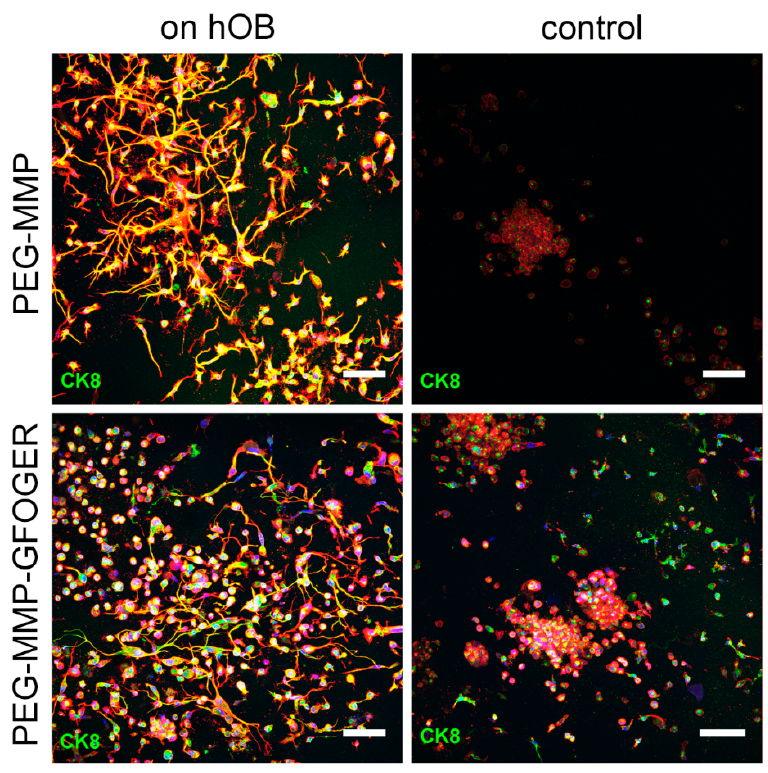
Figure 4. Maximum projection and 3D reconstruction images of MDA-MB-231 cultured on hOBs in a 2D–3D coculture model. Cells were either cultured in PEG–MMP ( γ = 1) ( top row ) or PEG–MMP–GFOGER ( γ = 1.25) ( bottom row ) hydrogels for 21 d. Cells cultured on hOBs in both hydrogel types showed long protrusions in comparison to more spherical control cells. Staining represents f-actin (red), nuclei (blue), and CK8/18 staining (green). Scale bar = 100 µm.